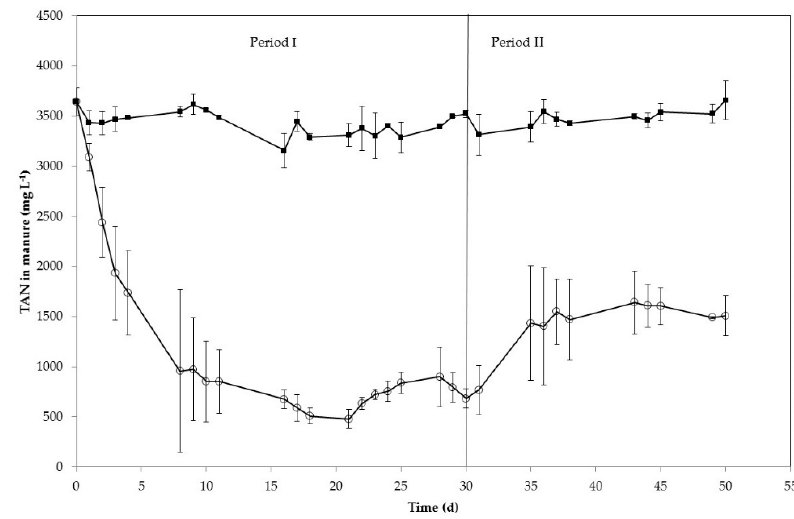
Figure 2. TAN concentration in the influent swine manure ( (cid:4) ) and in effluent of the gas-permeable membrane system ( ). The error bars represent the standard deviation of duplicate experiments. (cid:35)